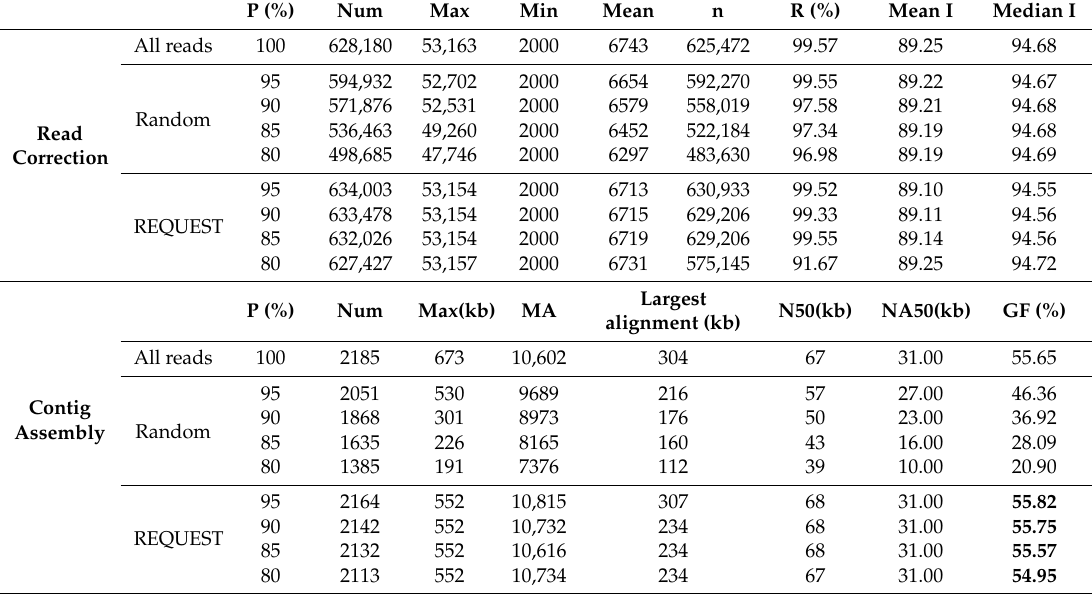
Table 1 . Summary of the results of Escherichia coli in selection, correction, and contigs. REQUEST— Read Quality Evaluation and Selection Tool.